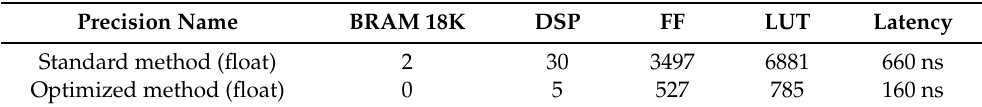
Table 1. Hardware report for CT pre-processing core (instance for 1 pixel per clock cycle).